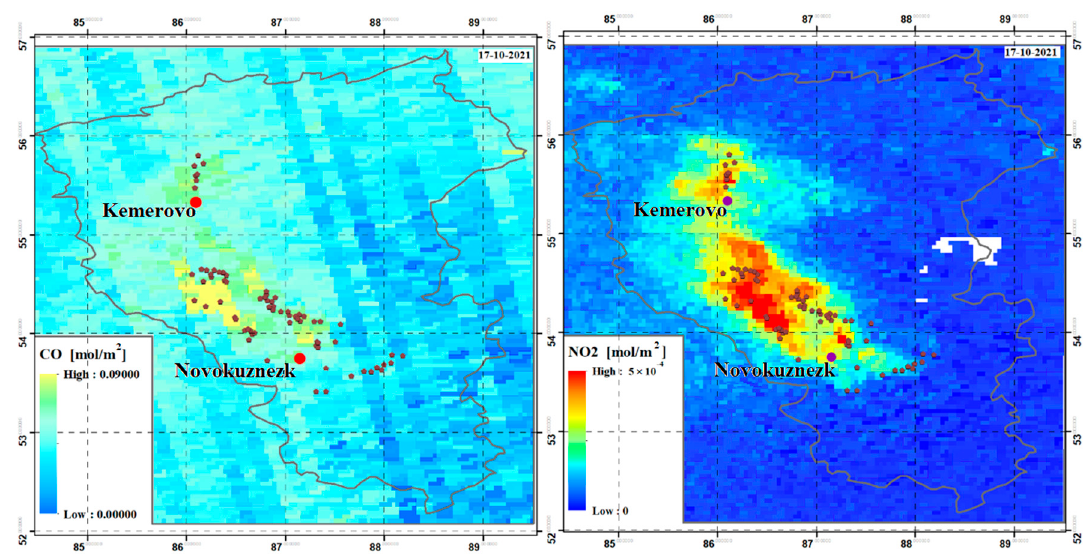
Figure 9. High CO ( left panel ) and NO 2 ( righ panel ) emissions, registered on 17 October 2021. Data used—Sentinel-5P.